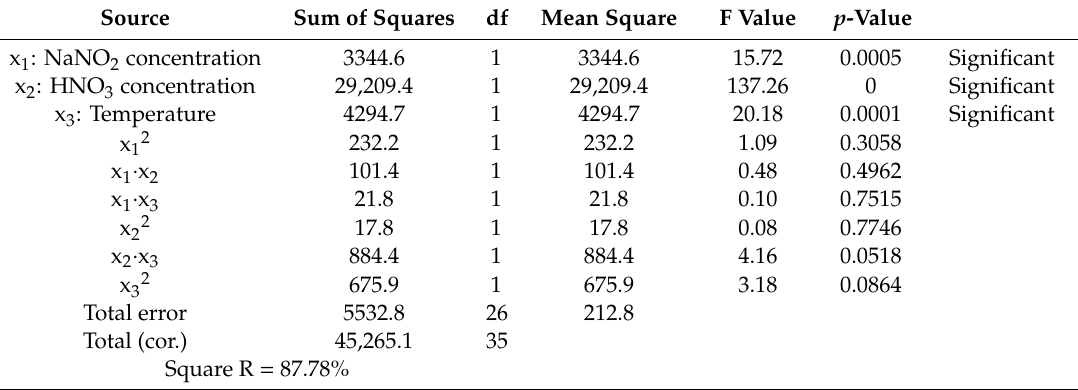
Table 3. ANOVA for the response surface quadratic model where response was TOC removal after 120 min, Y 2